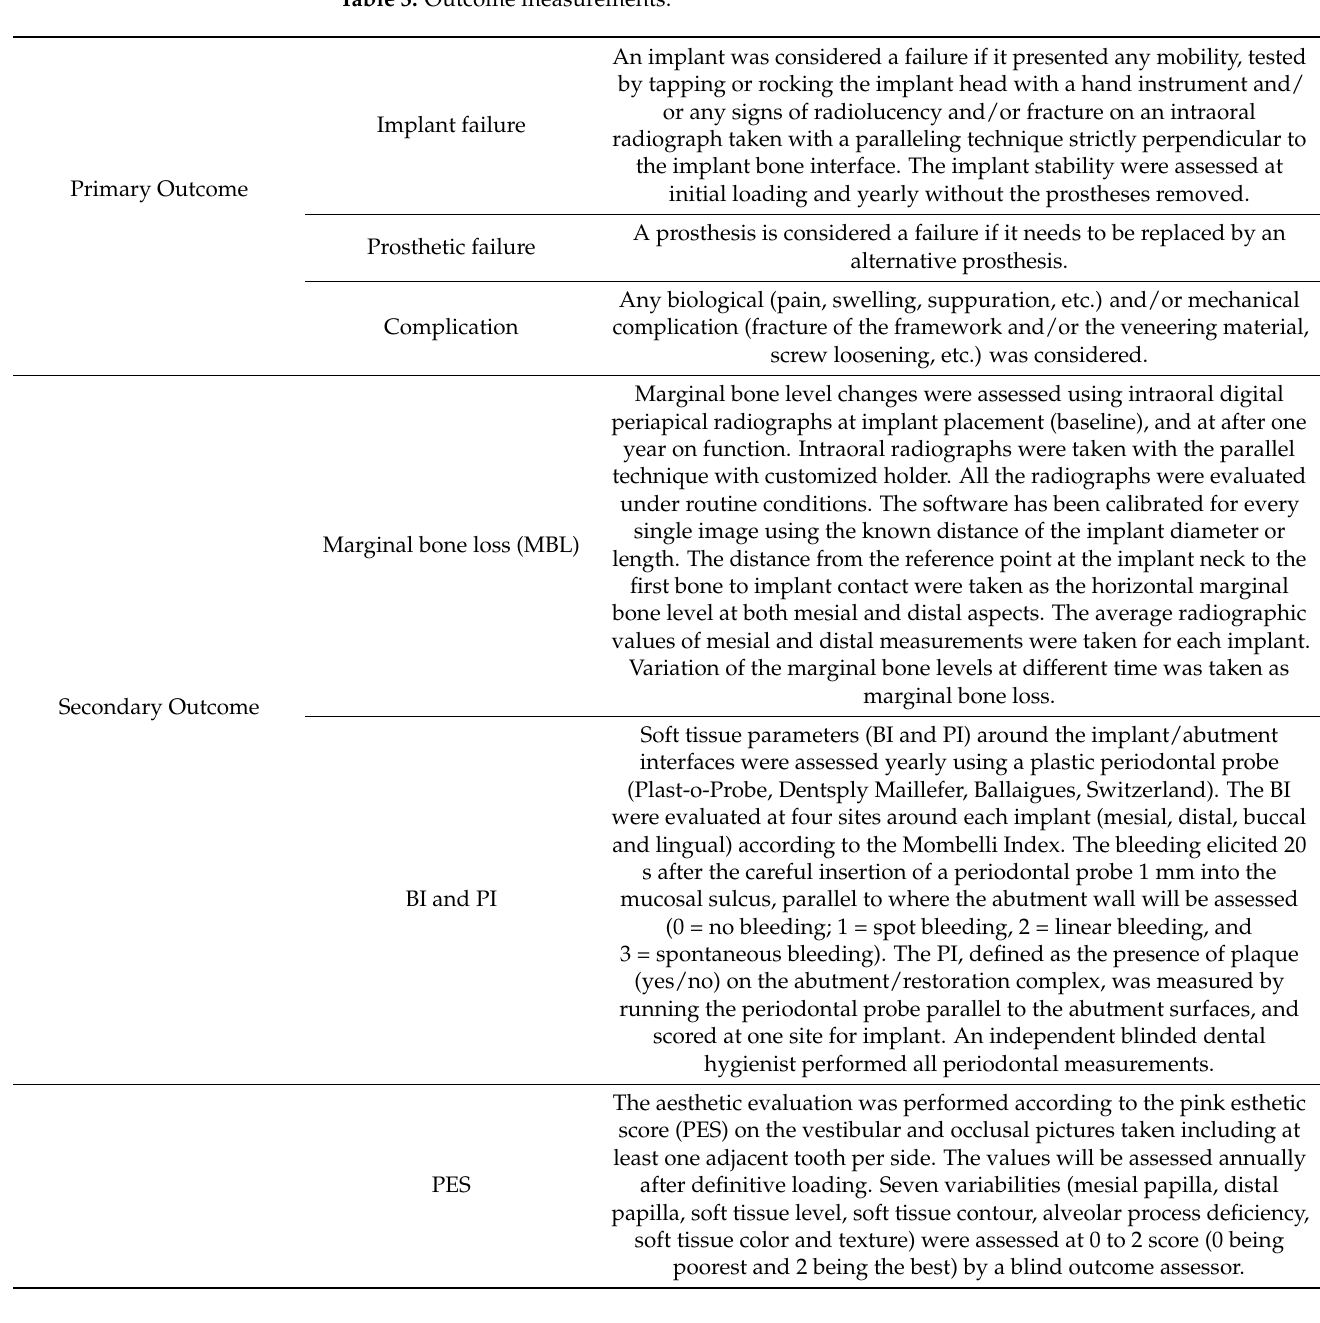
Table 3. Outcome